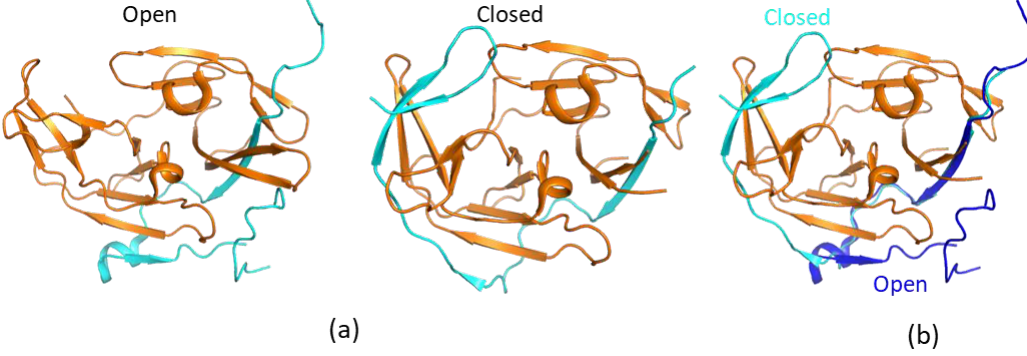
Figure 2. Open and closed conformations of the proteases. ( a ) Open and closed conformations of WNV protease. The non-structural protein 2B (NS2B) and NS3pro are shown in cyan and orange, respectively. ( b ) Structural comparison of open and closed proteases. The structures of open (PDB identifier (ID) 2FOM) and closed (PDB ID 2FP7) proteases are shown. The NS2B C-terminal portion from the cofactor is away from the active site to form an open conformation. NS2B in the open and closed conformations is shown in blue and cyan, respectively. To make it clear, only NS3 from the closed conformation is